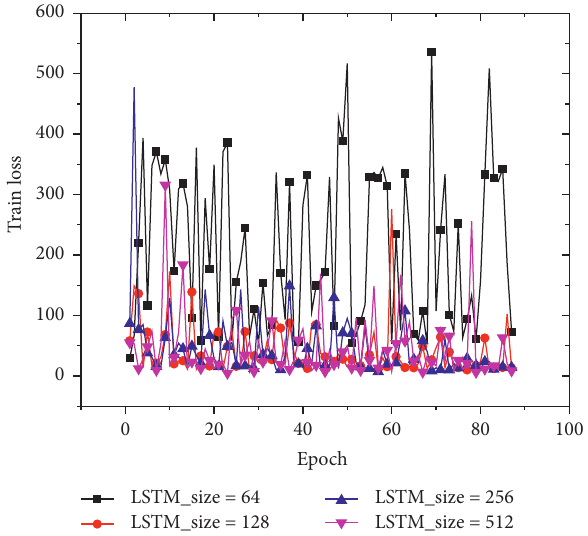
Figure 11: Training loss with different LSTM_sizes . Table 3: Average test loss with different LSTM_size in